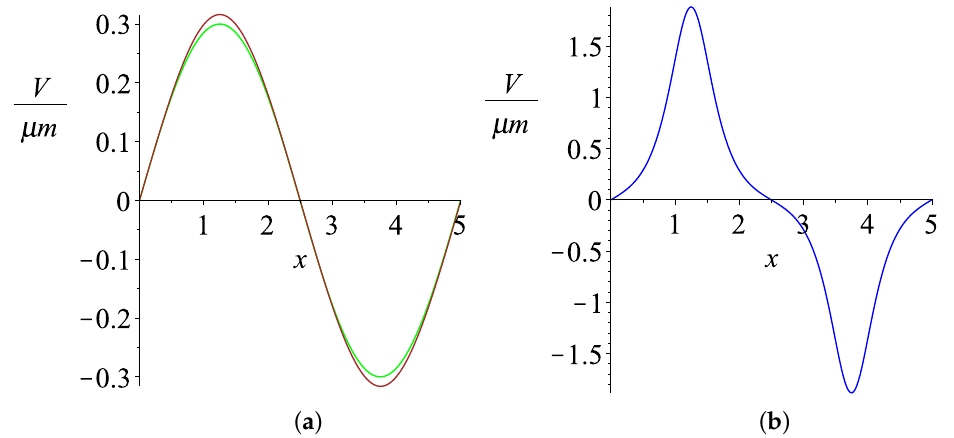
Figure 10. Subfigure ( a ): the eigenfunctions of problem (green curve) corresponding to the propagation constants denoted by the green and brown diamonds in Figure 2. Subfigure ( b ): the eigenfunction corresponding to the propagation constant of problem denoted by the blue diamonds in Figure 2. P α